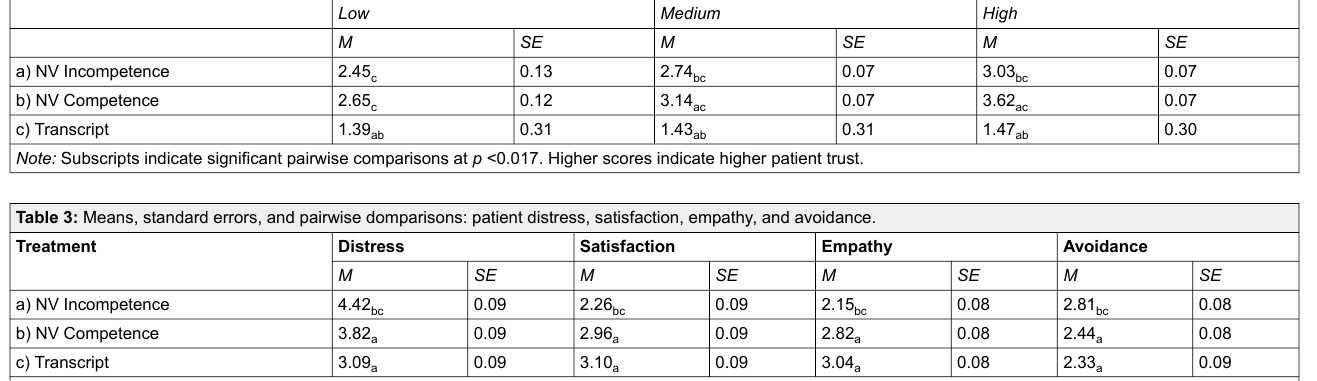
Table 2: Means, standard errors, and pairwise comparisons: post-treatment patient trust, controlling for general trust in physicians. General Trust in PhysiciansTreatment